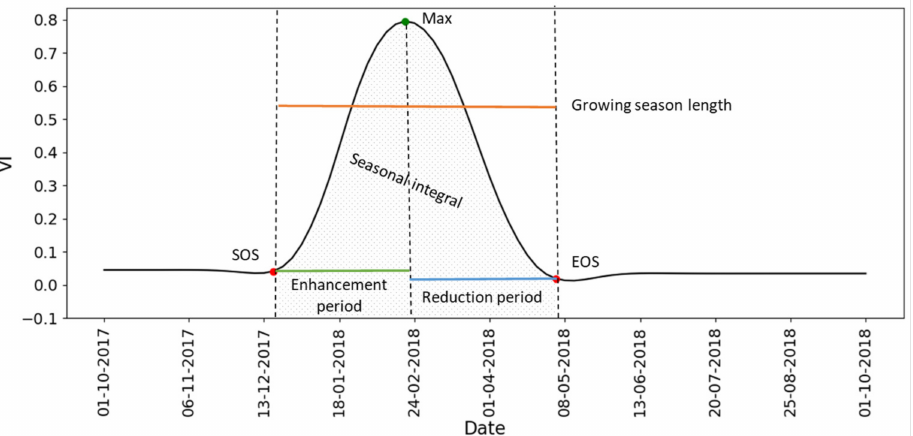
Figure 3. Phenology features. The x-axis value of the left red dot represents the SOS date, and the y-axis value of the left red dot represents the SOS VI value. The x-axis value of the right red dot represents the EOS date, and the y-axis value of the right red dot represents the EOS VI value. The x-axis value of the green dot represents the maximum date, and the y-axis value of the red dot represents the maximum VI value. The orange, green, and blue lines represent the growing season length, the length of the enhancement period, and the length of the reduction period,